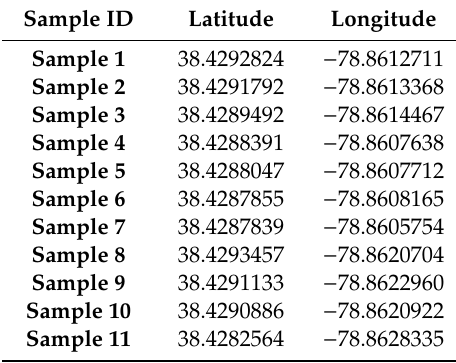
Table 2. GPS location of the sample